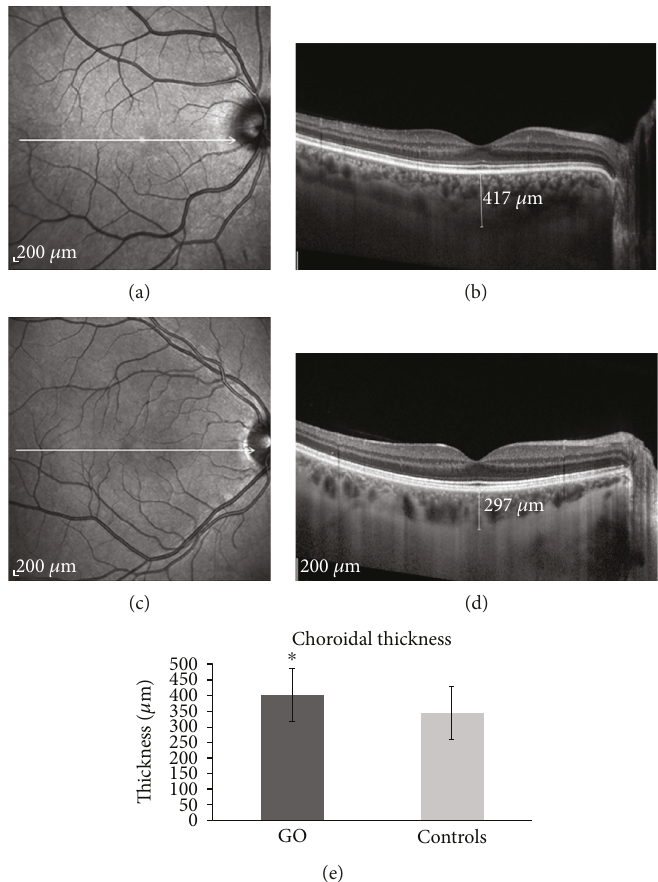
Figure 3: Subfoveal choroidal thickness measured by EDI SDOCT in a patient with Graves ’ orbitopathy (a, b) and in a healthy control (c, d). The graph (e) shows the signi fi cant increase of choroidal thickness (mean ± SD) in patients with Graves ’ orbitopathy ( n = 18 ) versus controls ( n = 18 ) ( ∗ p < 0 01